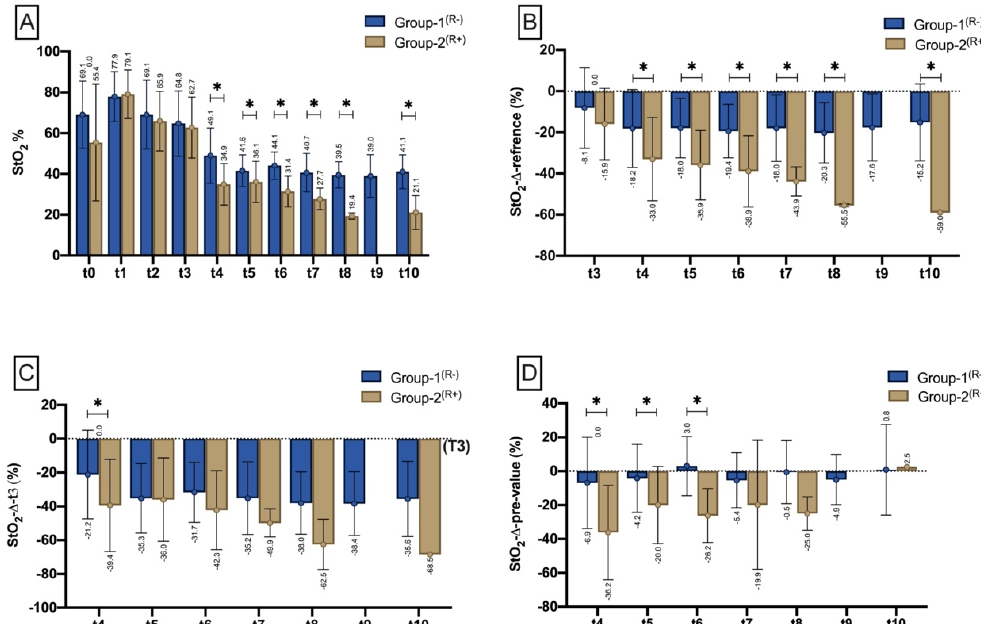
Figure 4. Bar chart with means ( ± SD) show StO 2 at different measurement timepoints (T0–T3)/time intervals (t4–t10) as ( A ) (StO 2 mean), ( B ) StO 2 drop to reference (%) StO 2 drop to the respective reference site (StO 2 ∆ reference), ( C ) StO 2 drop to t3 (StO 2 Δ t3), and ( D ) in relation to the pre-measurement (StO 2 Δ pre-value). Means are shown scalar. Asterisk (*) marks existing significance.